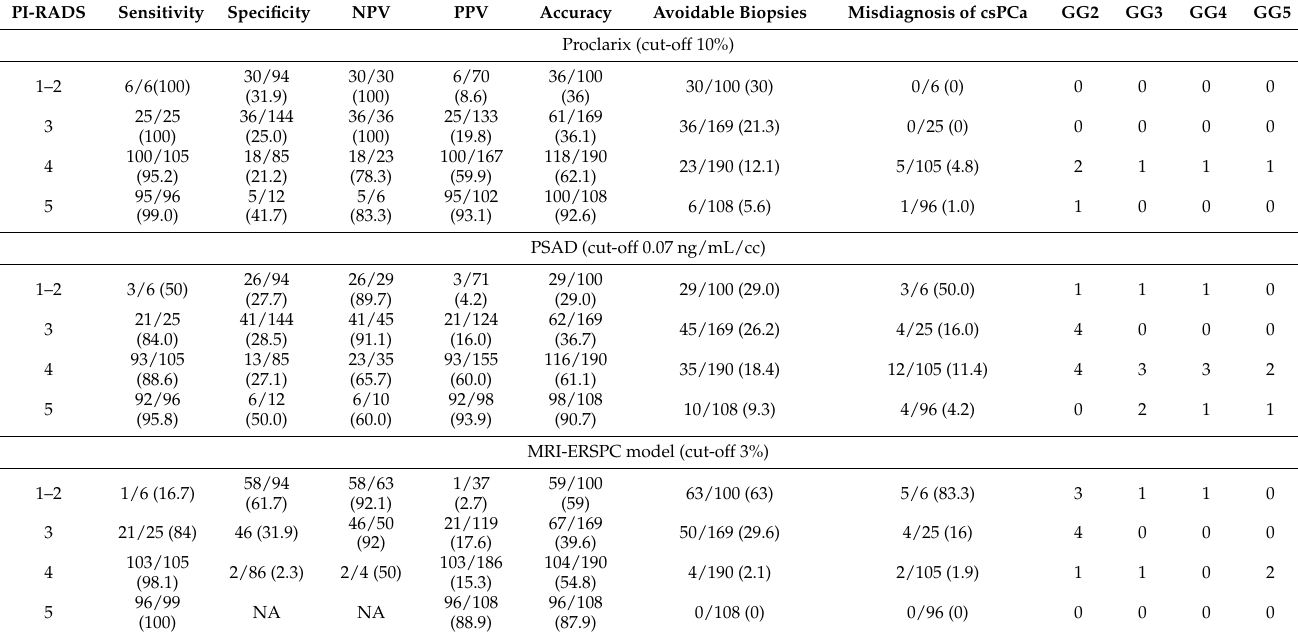
Table 3. Characteristics of Proclarix, PSAD and MRI-ERSPC regarding PI-RADS